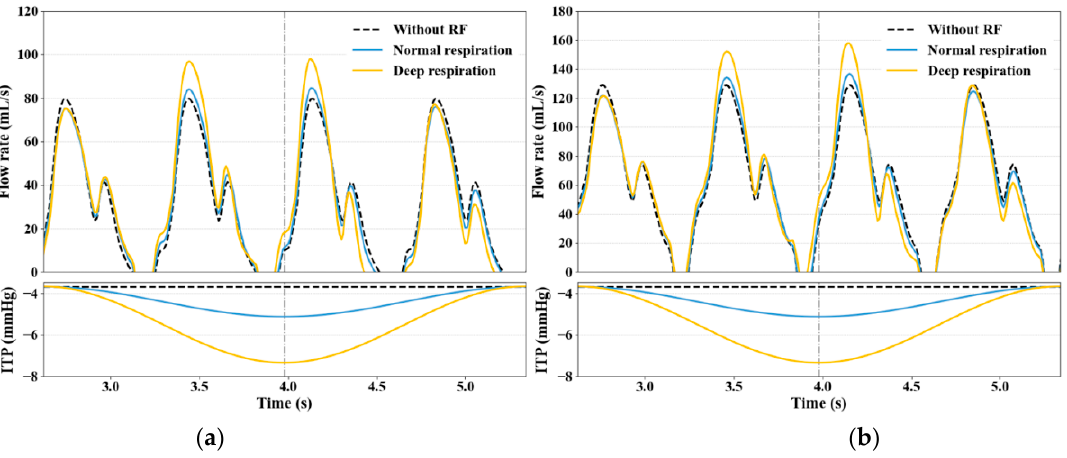
Figure 7. Flow rates and ITPs in SVC ( a ) and IVC ( b ) of an adolescent subject in normal and deep breathing modes and without RF effect.